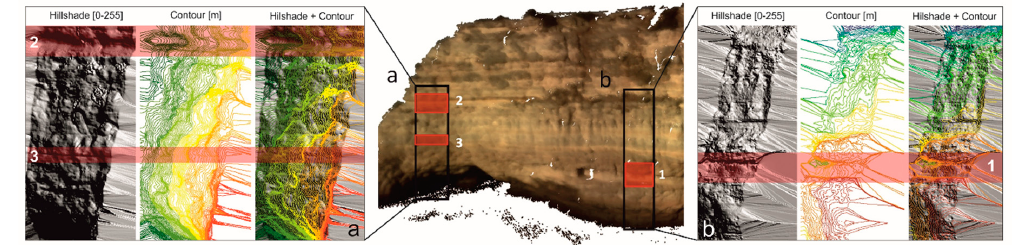
Figure 8. Hill shade, contour, and combined (superimposed) maps of the cliff, and detected notch positions ( a , b ). Numbers 1–3 represent locations of analyzed notches.